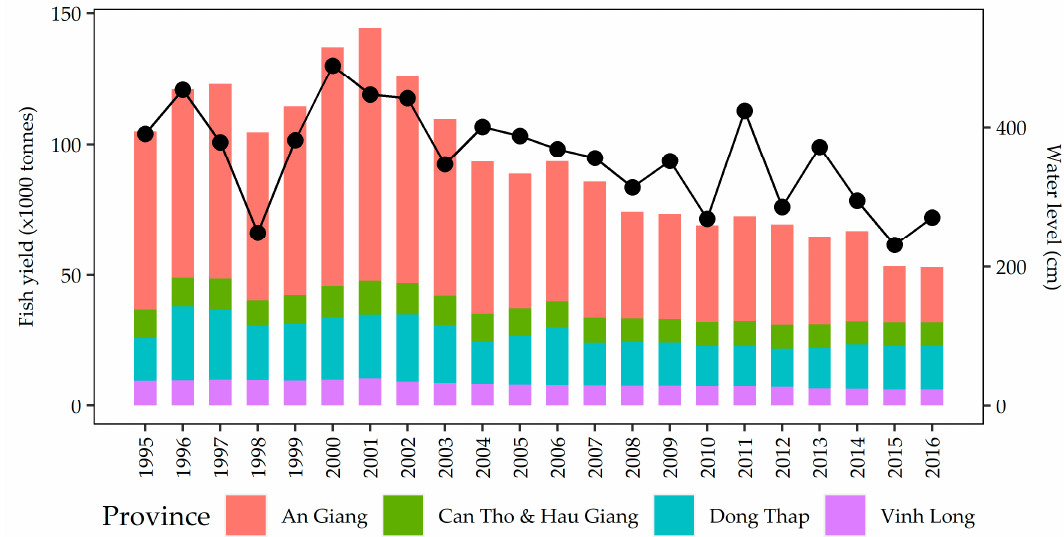
Figure 6. Trend of officially recorded commercial catches (bar chart) and maximum annual water level (line) for over 20 years period in the Mekong Delta. Data from inland provinces only; water levels recorded at Chau Doc Station, Bassac River.